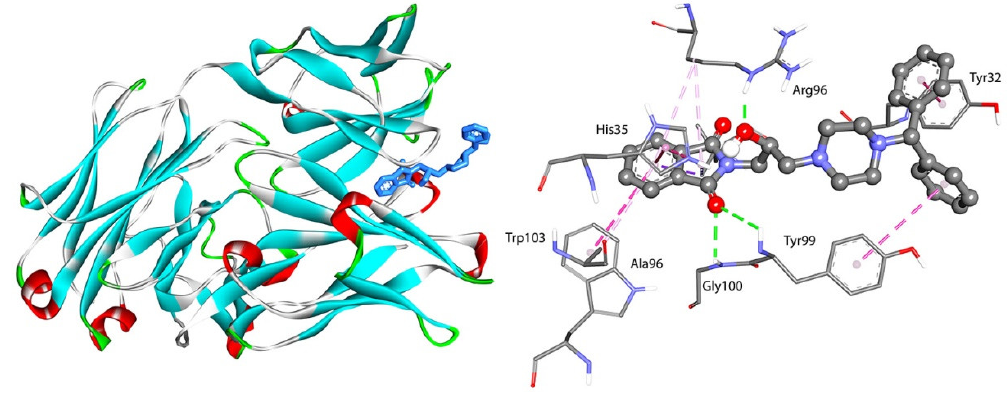
Figure 10. The 2D interaction plots of compounds F1–F4 with AAG.